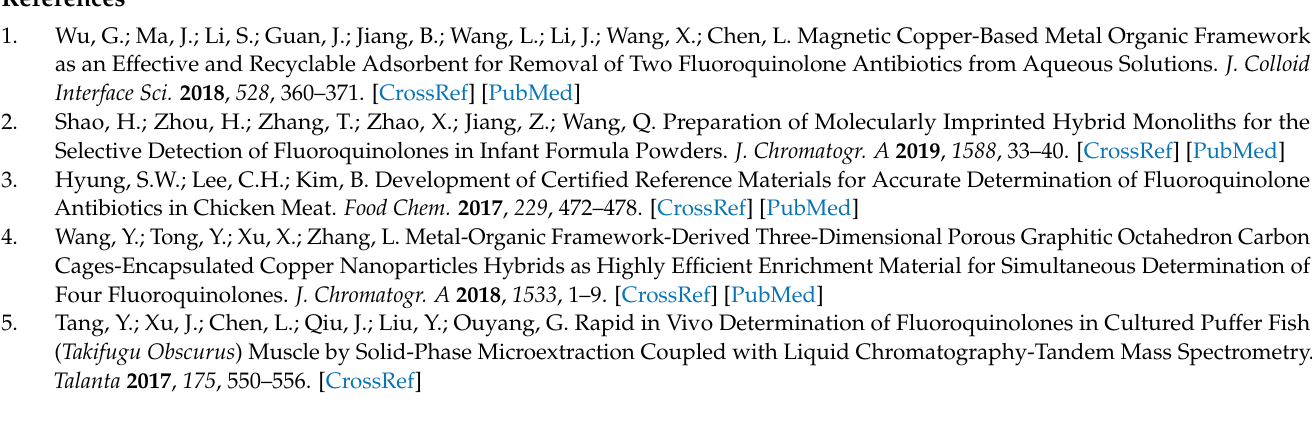
ture; Figure S3: Results of detecting enrofloxacin in fish meat at the concentrations of 10, 100, and 500 nM. Figure S4: Results of detecting enrofloxacin in chicken meat at the concentrations of 10, 100, and 500